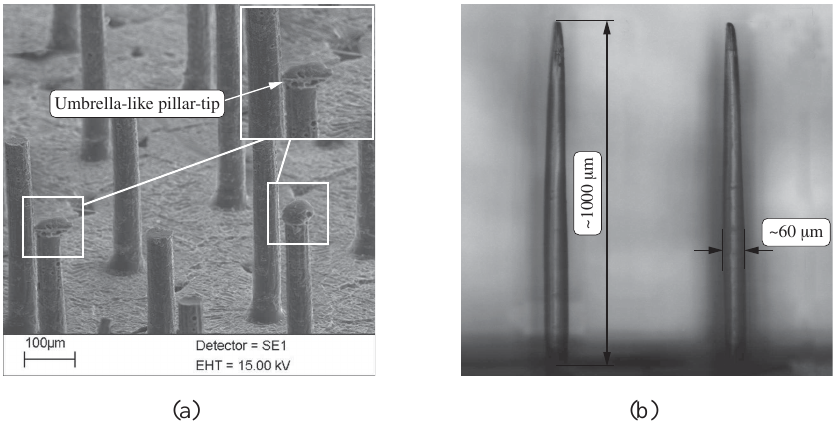
Figure 2. ( a ) Umbrella-like air inclusion during casting due to insufficient evacuation during fabrication and remaining gaps between wax mold and carrier substrate. ( b ) Typical pillar geometry mold in a blind hole evidencing a reduced diameter close to the pillar tip.